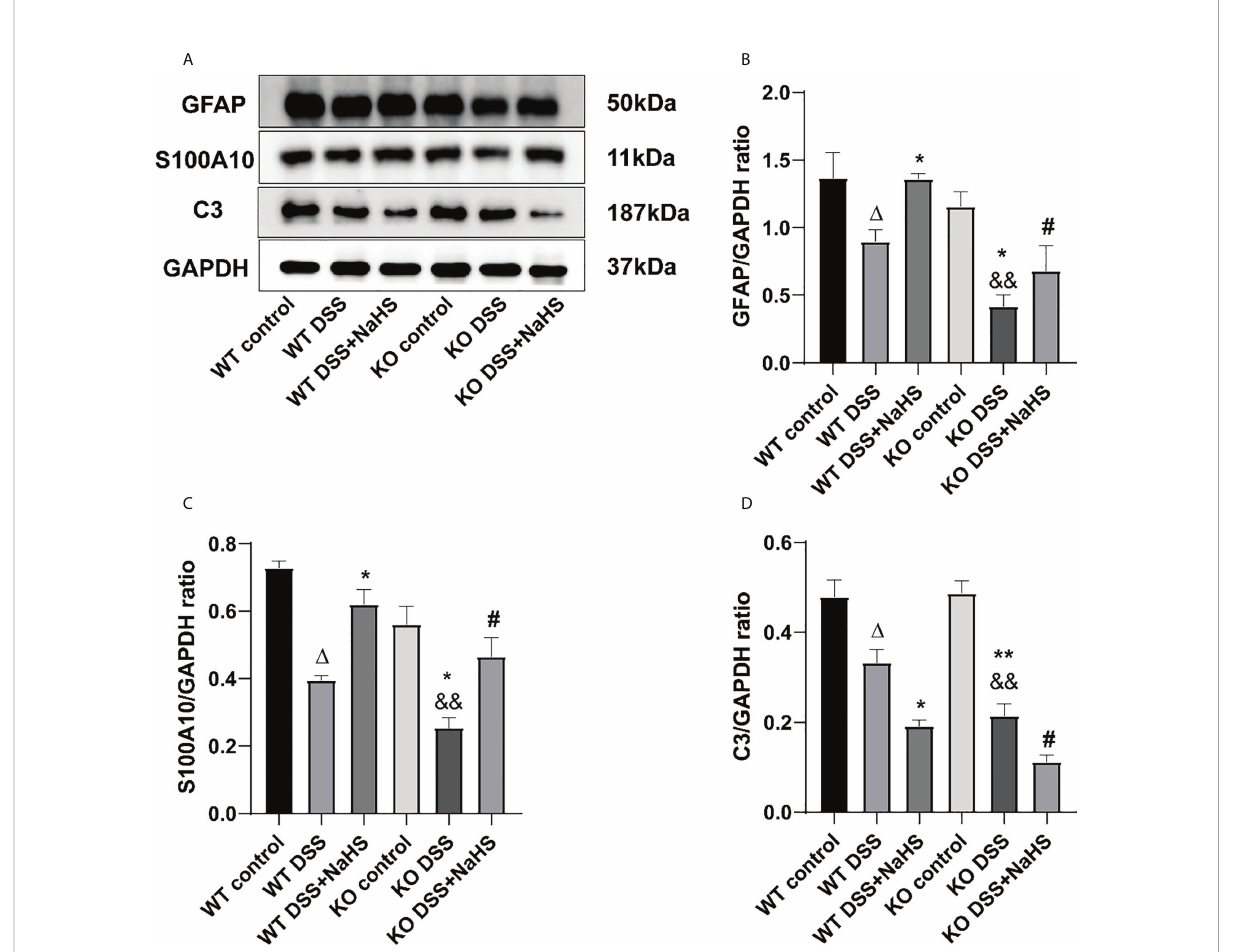
FIGURE 8 Effects of cystathionine- g -lyase (CSE)-derived hydrogen sul fi de (H2S) on the expression of glial fi brillary acidic protein (GFAP), S100A10, and C3 proteins in colon. Data are expressed as the mean±SEM, N=3. (A) The bands of GFAP, S100A10, and C3. (B) The relative expression of GFAP in colon. (C) The relative expression of S100A10 in colon. (D) The relative expression of C3 in colon. D P<0.05 vs wild-type (WT) control group; *P<0.05, **P<0.01 vs WT dextran sodium sulfate (DSS) group; && P<0.01 vs knockout (KO) control group; # P < 0.05 vs KO DSS